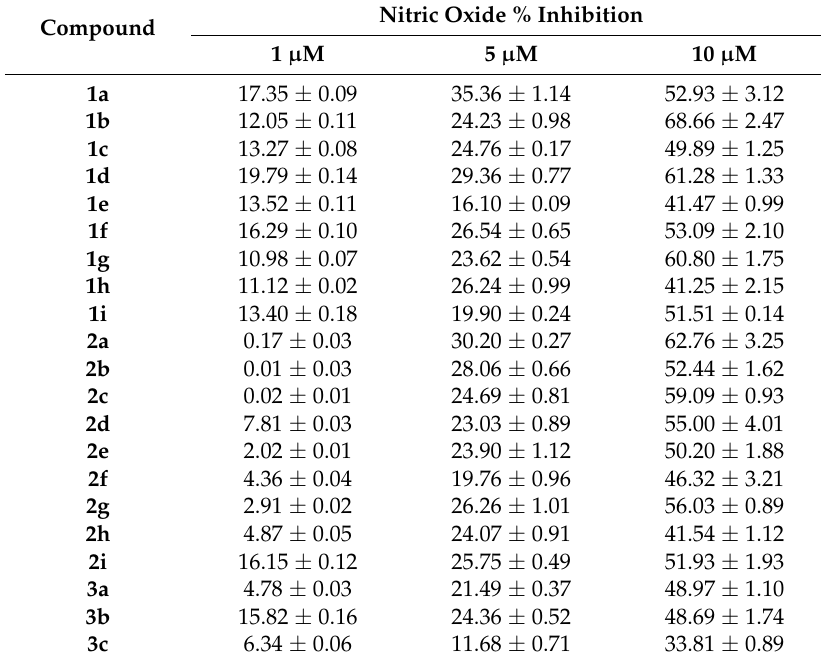
Table 2. Nitric oxide production inhibition of the final target compounds at different dose